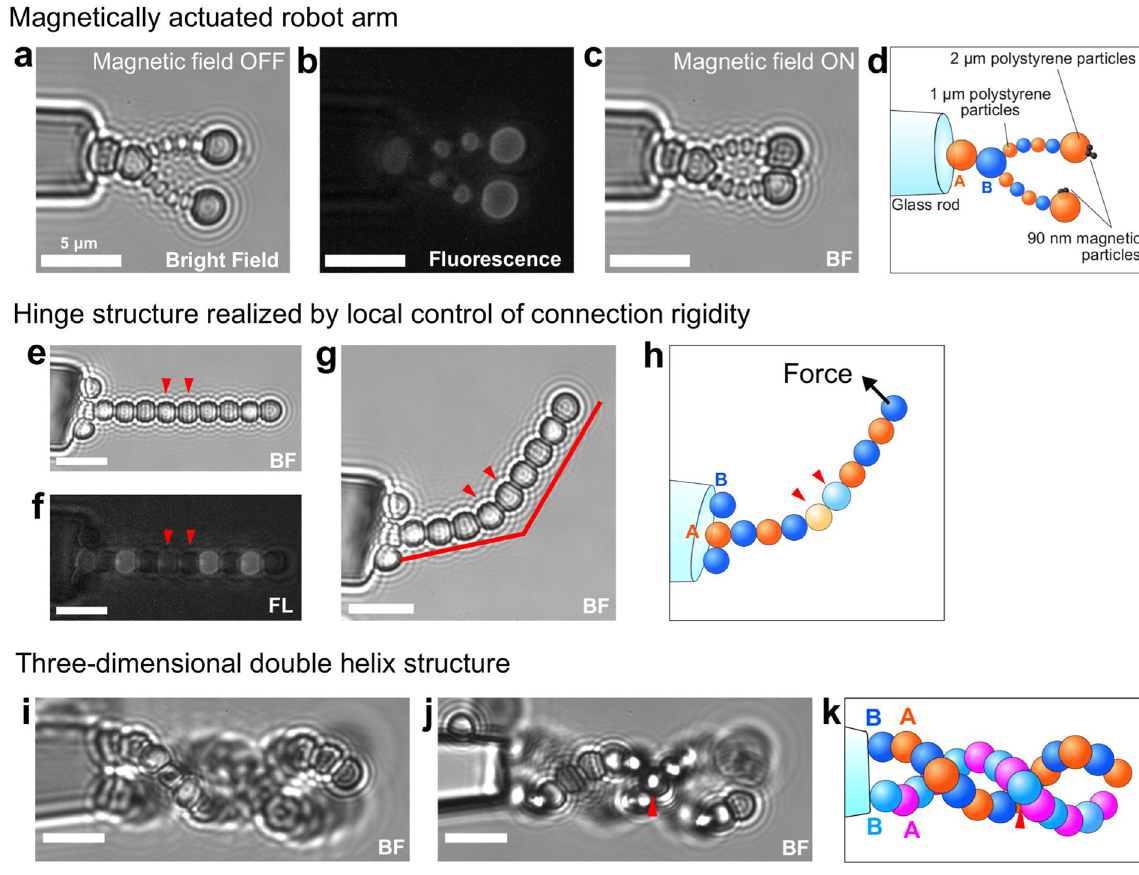
Figure 3. Microscopic structures assembled with the described method. ( a ) A microscopic robot arm actuated by an external magnet. The arm consists of 2- μ m and 1- μ m particles. Multiple 90-nm magnetic particles are fixed on the two tip particles. The arm opens and closes in response to an external magnet field. ( b ) Fluorescence image of the robot arm. Only strand A was modified with a HEX fluorescent dye on its 5 ′ end so that the A particles and B particles could be distinguished during the assembly process. ( c ) The robot arm closes when a permanent magnet (0.28 Tesla, diameter = 6 mm and height = 3 mm) is placed close to the chamber. ( d ) The schematic corresponding to ( c ). ( e ) Hinge structure. The primer A particle is supported by the B particles on the sides. The two particles indicated by red arrows have lower DNA densities than the other particles on the surface. The connections with these particles are more flexible and serve as a hinge. ( f ) Fluorescence image of the hinge structure. The fluorescence of the particles serving as the hinge is weak because of the low DNA density. ( g ) The structure bends at the hinge site when the tip particle is manipulated by the optical tweezers with a 40-mW laser. ( h ) The schematic corresponding to ( g ). ( i,j ) Three-dimensional double-helix structure. The two particle chains contact only at the point indicated by the red triangle. ( i and j ) show the images observed at different focal planes. ( k ) The schematic corresponding to ( i and j ). The two chains were drawn in different colors for ease of identification. Scale bars indicate 5 μ m. BF and FL denote bright field observation and fluorescent observation,